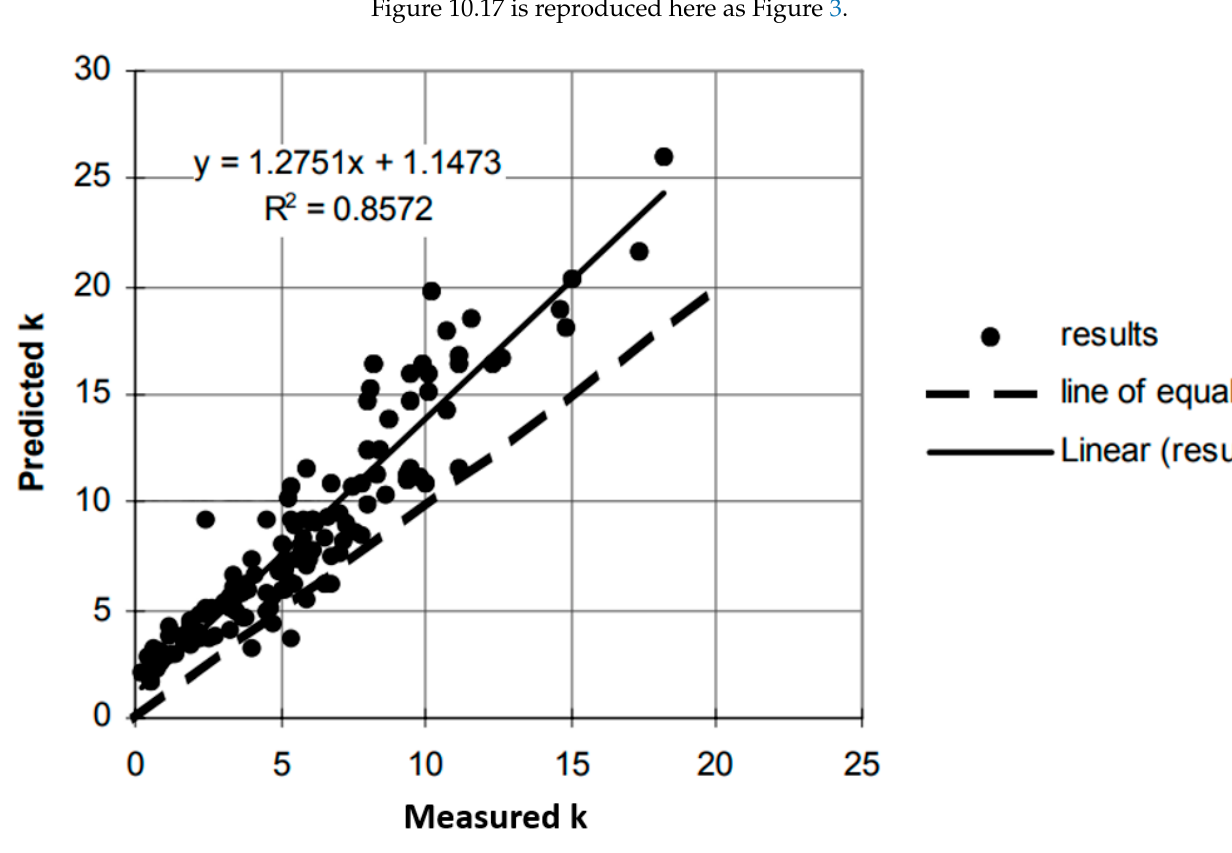
Figure 3. Predicted k vs. measured k, from Bamforth [8]. Adapted with permission from [8] Copyright 2004, The Concrete Society.